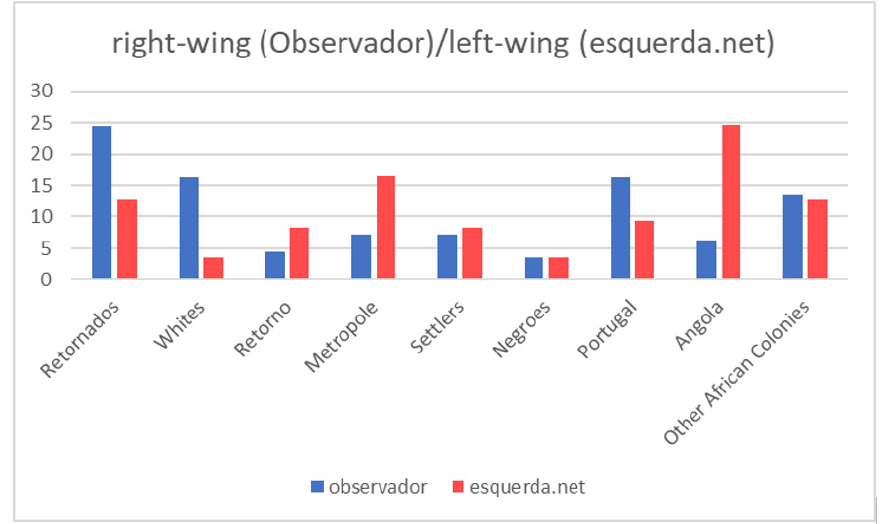
Figure 8. Comparison of text 1 of the Observador and text 1 of esquerda.net.